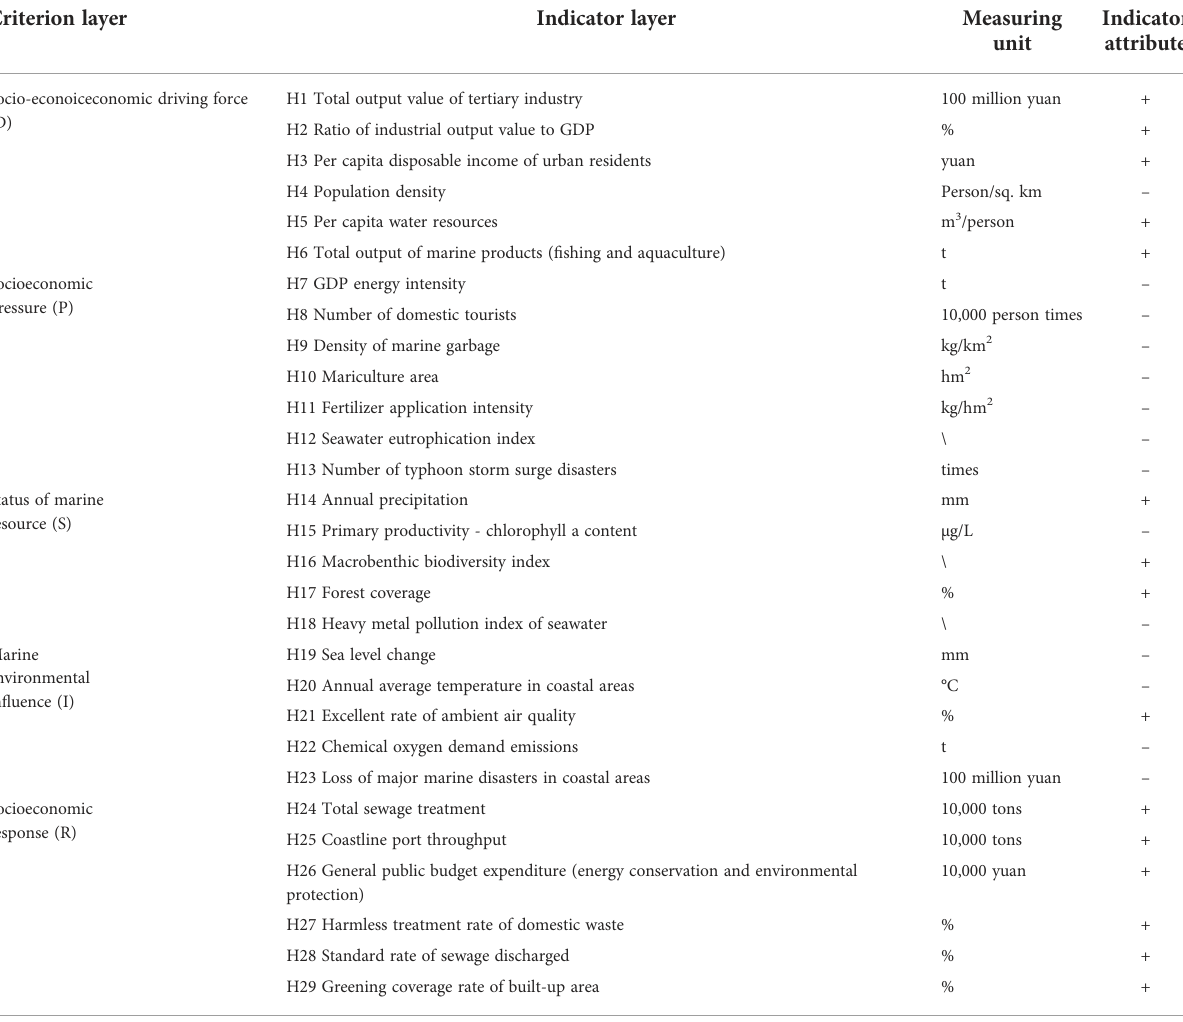
TABLE 3 Ecological security evaluation index system of coastal zone based on DPSIR